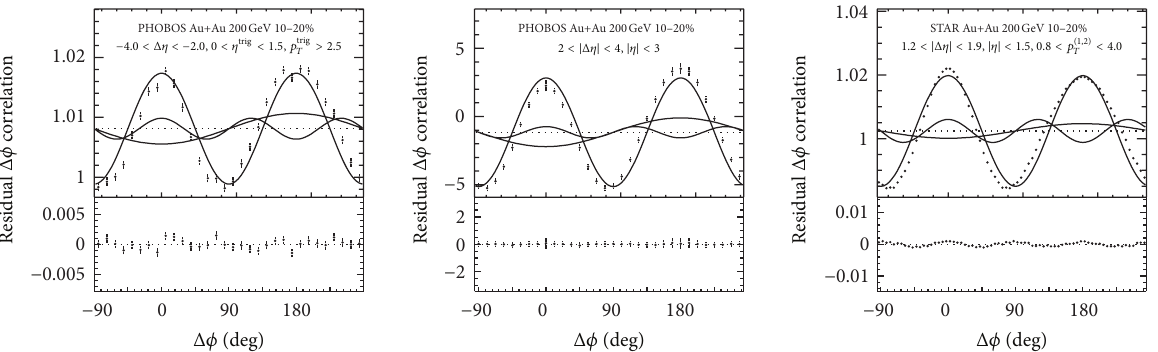
Figure 14: Azimuthal correlation functions for midcentral (10–20%) Au+Au collisions at √𝑠 𝑁𝑁 = 200 GeV obtained from projections of two-dimensional Δ𝜙 − Δ𝜂 correlation measurements by PHOBOS [19, 25] and STAR [41]. The residual correlation functions after the first three Fourier components that are subtracted are shown in the bottom panel. The figure is from [115].